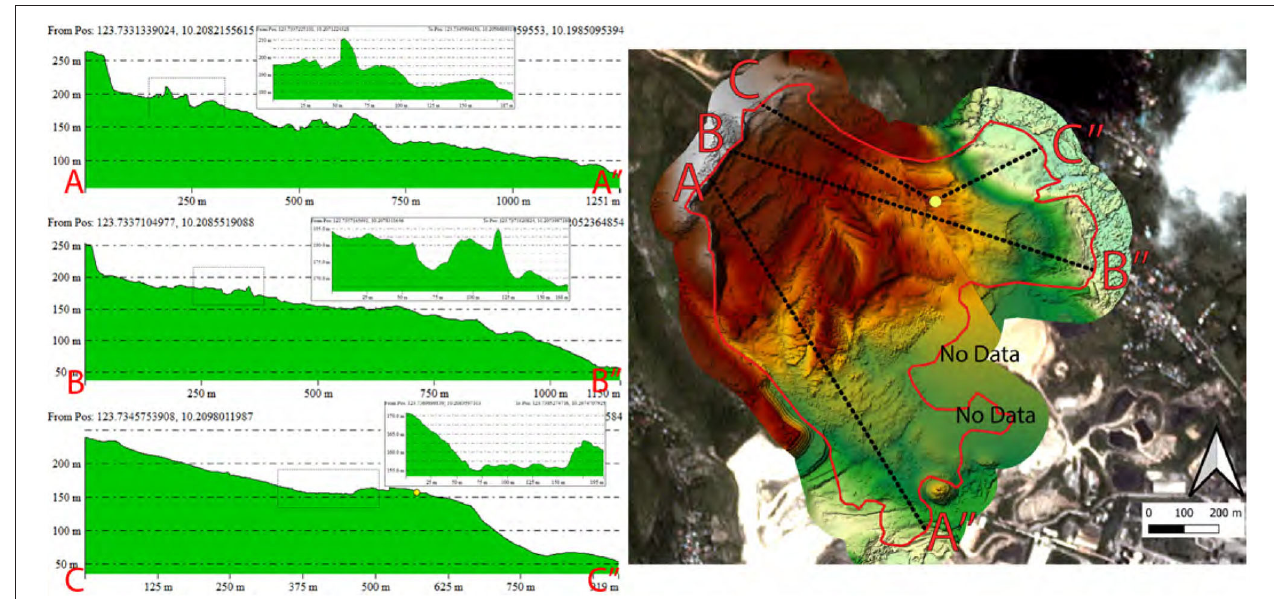
FIGURE 4 | Cross sections of the Naga landslide based on a DEM generated from drone images.